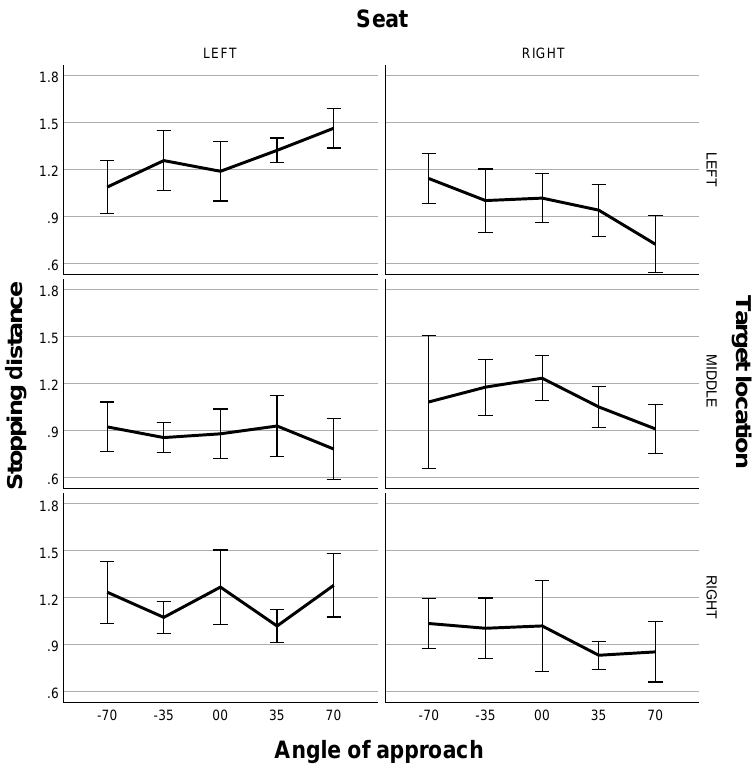
Figure 9. Average stopping distance (in meters) per angle of approach (ranging from − 70 ◦ to + 70 ◦ ), seat, and target location in study 3: Whiskers represent 95% confidence